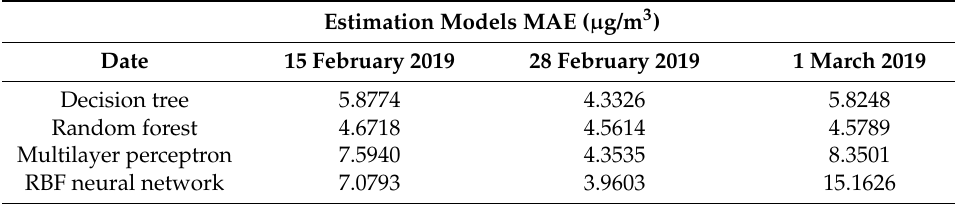
Table 4. MAE values of the learning models.